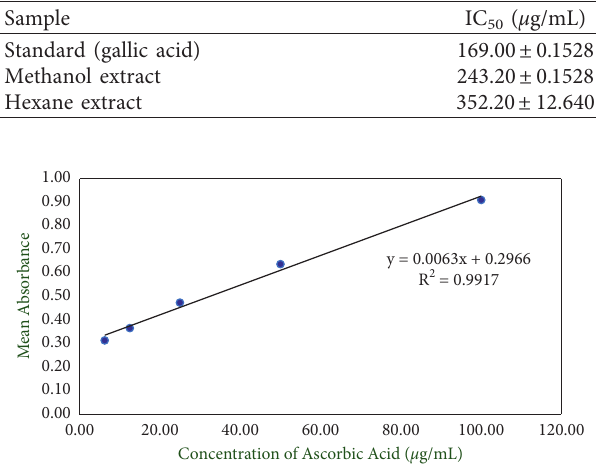
VI 407- (formed in 4 Mo 8 O